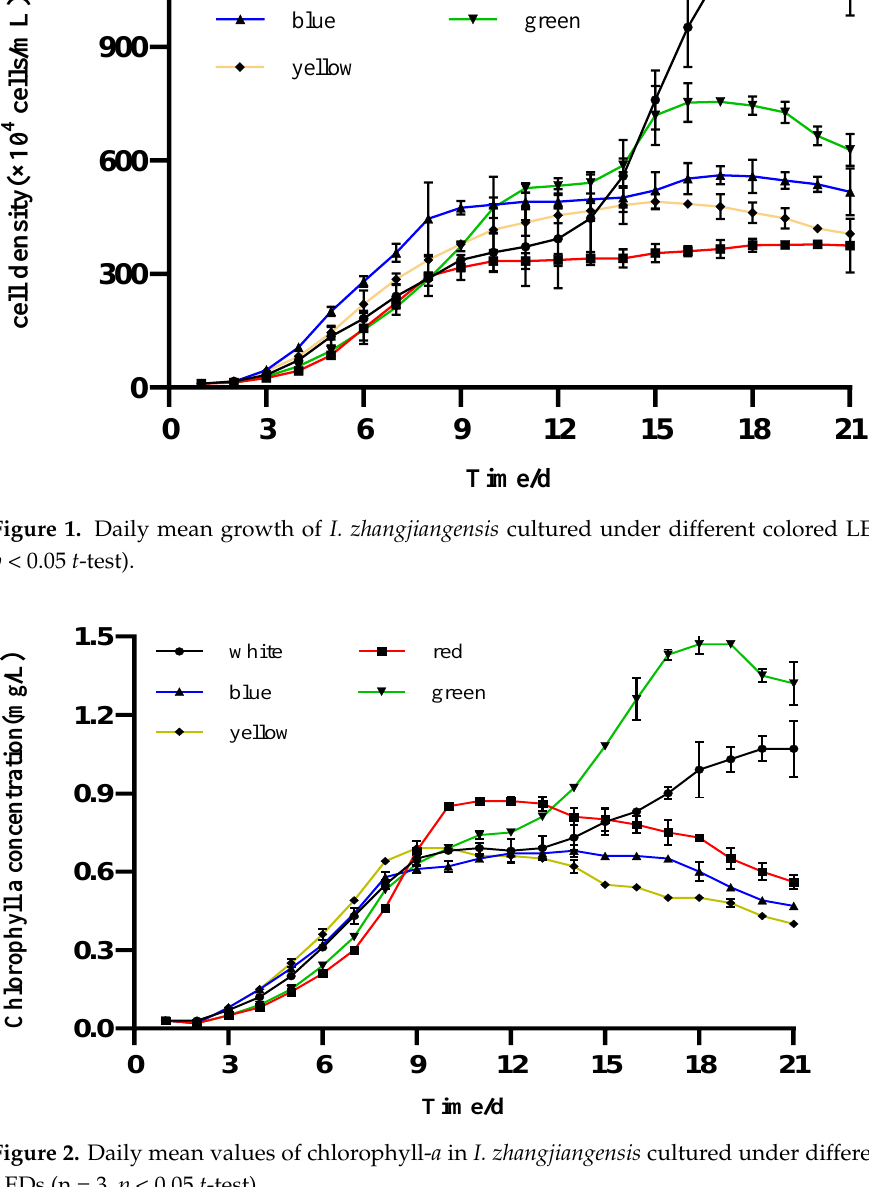
Figure 1. Daily mean growth of I. zhangjiangensis cultured under different colored LEDs (n = 3, p < 0.05 t -test).